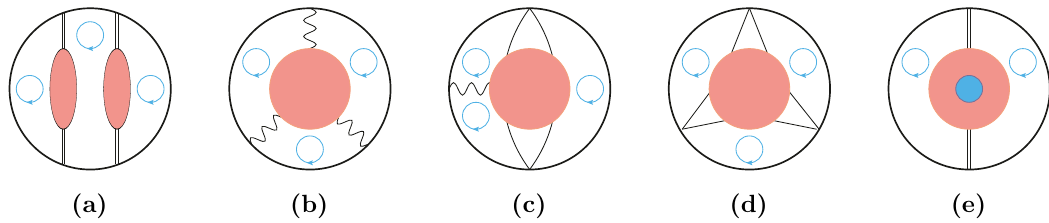
Figure 5. Diagrams contributing to the latitude Wilson loop expectation value at sub-leading N 2 order, which is N 2 N l (cid:0) 2 at l loops. The blue circles represent loops in N 1 color space, giving 1 2 rise to N 1 powers. To this order in the color limit, only three N 1 loops are allowed, which after normalization give rise to the desired N 2 factor. Solid lines stand for scalars, whereas wavy for 1 gluons. Red bubbles represent all quantum corrections with maximal N 2 power at each perturbative order. The double line in diagrams ( a ) and ( b ) represent the combined exchange of a gluon and a scalar pair, from the connection